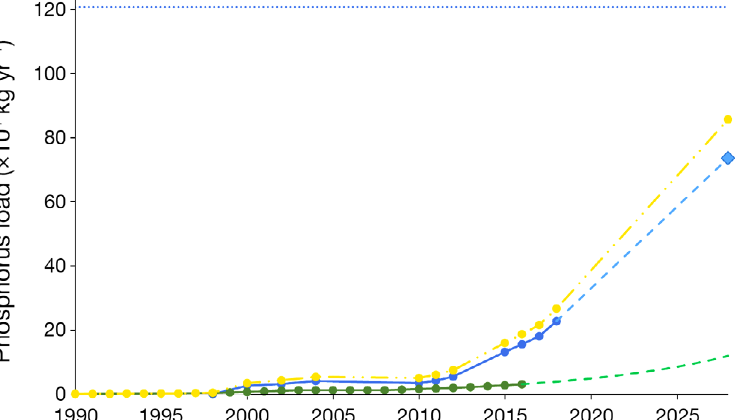
Fig. 5. Developments of total aquaculture P load (L tot ) (yellow) and P load from tilapia (blue) and crocodile (green) farms in Lake Kariba. For tilapia and croc- odile, solid lines indicate estimated P load as calculated from historical pro- duction data, and dashed lines indicate predicted P load based on growth ex- pectations. The total allowable P load in lake Kariba is indicated with the dotted horizontal blue line